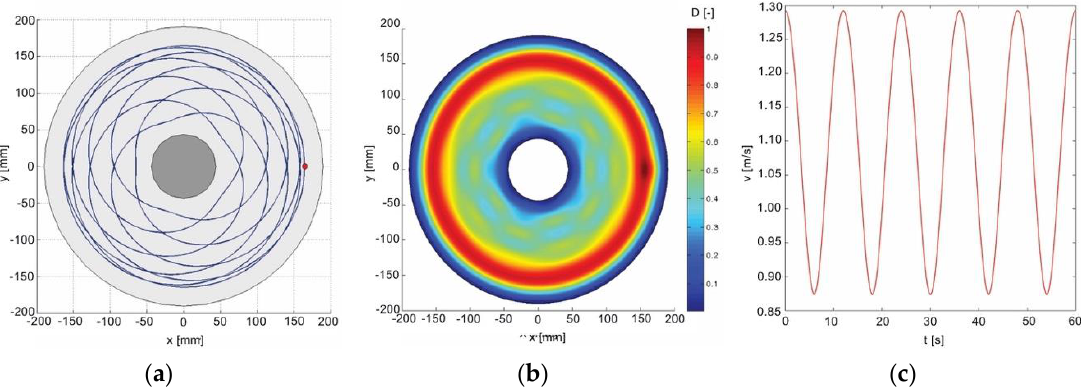
Figure 2. The influence of the parameter k 1 = − 5/9 on: ( a ) the shape of the abrasive grains trajectory; ( b ) the trajectories density on the lapping plate; and ( c ) the distribution of relative velocities v ( t ) .